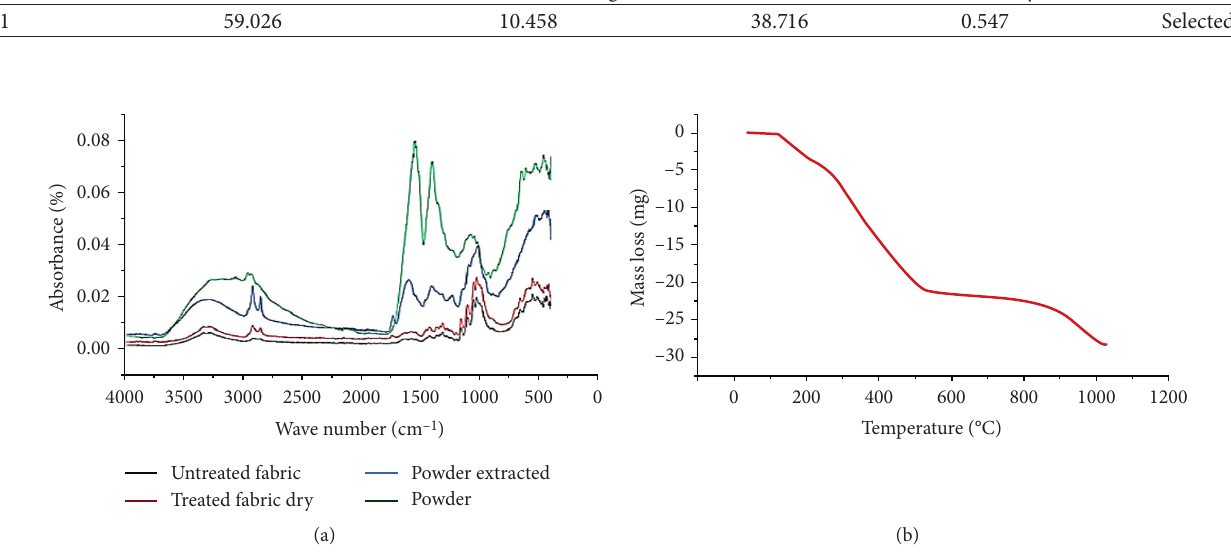
Figure 4: Functional group and thermal analysis of nettle leaf extracted powder: (a) combined FTIR spectra of untreated cotton fabric; (b) thermography resulting from TGA analysis, obtained under a nitrogen flow of 50ml/min and heating rate of 10 ° C/min.